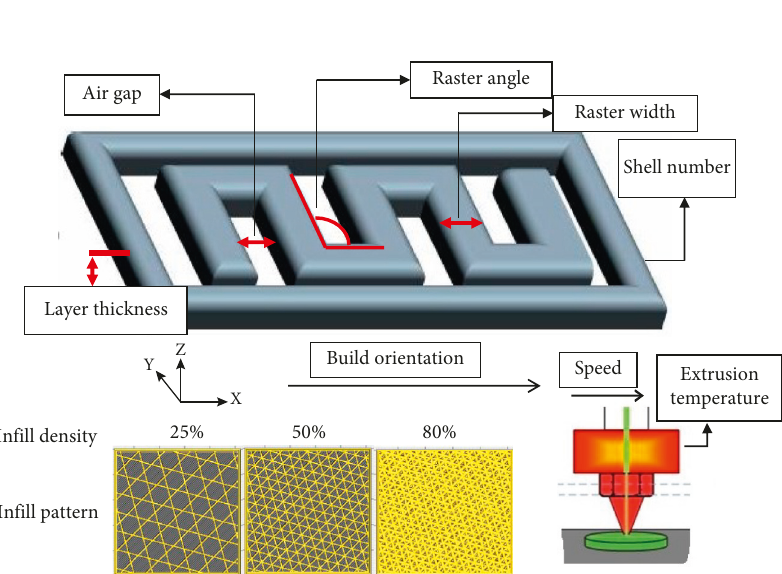
Figure 2: Diagrammatic representation of FDM process parameters